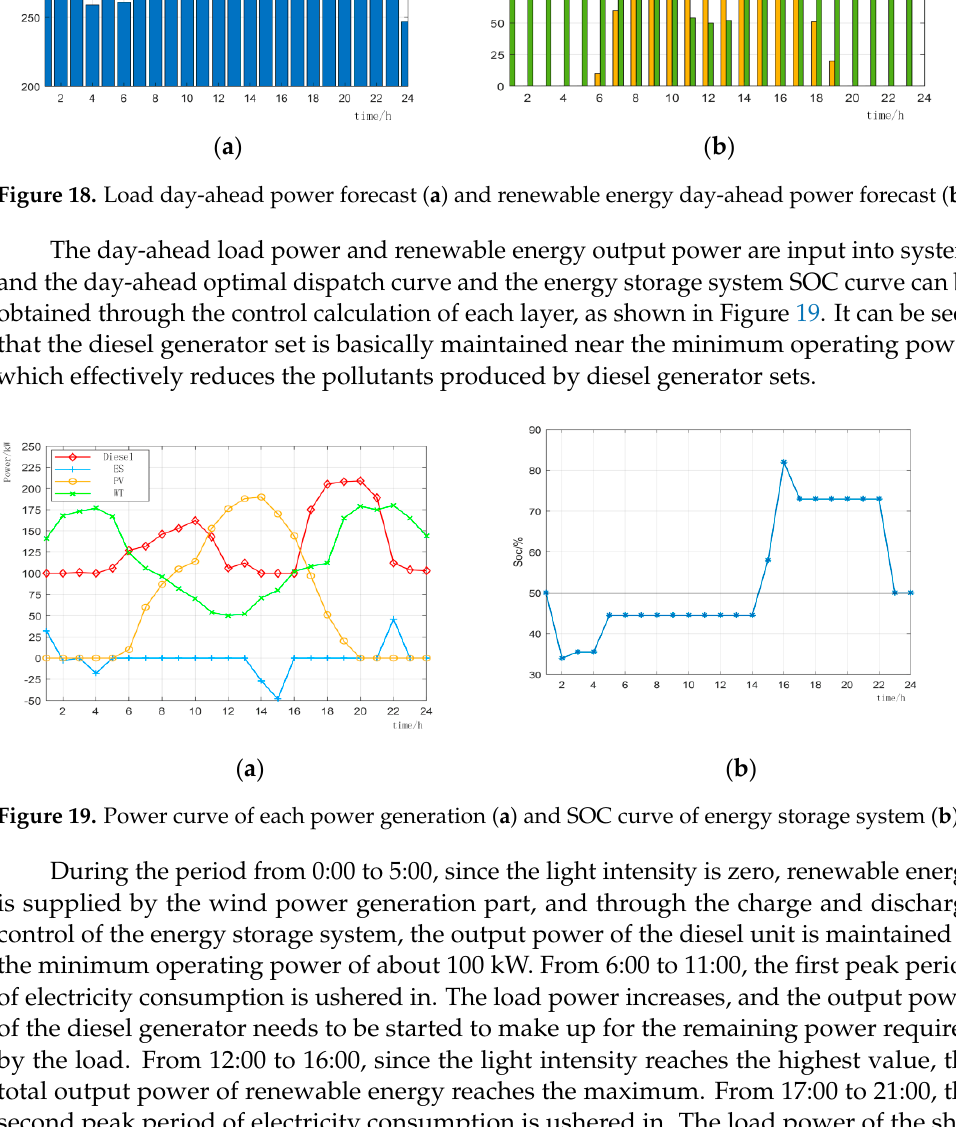
Figure 17. Simulation result of control system. ( a ) Current waveform; ( b ) Voltage waveform; ( c ) System frequency.